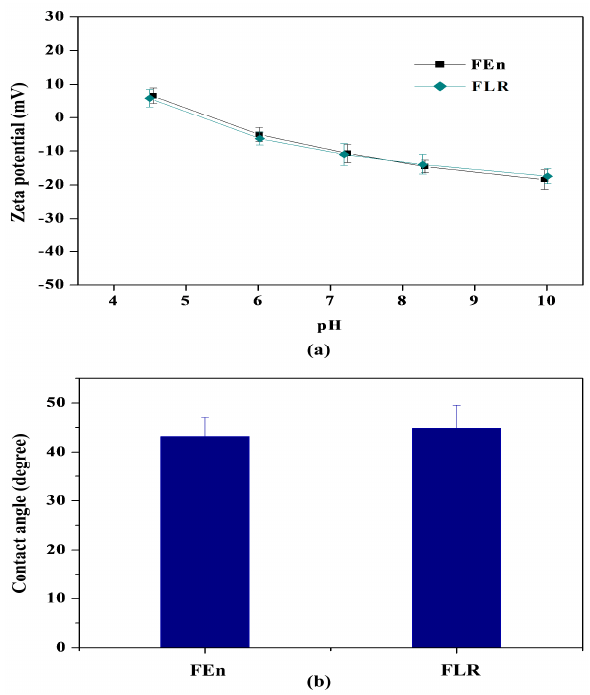
Figure 4. Comparison of surface characteristics of the membranes with different flow rates: ( a ) Zeta potential; ( b ) Sessile drop contact angle.